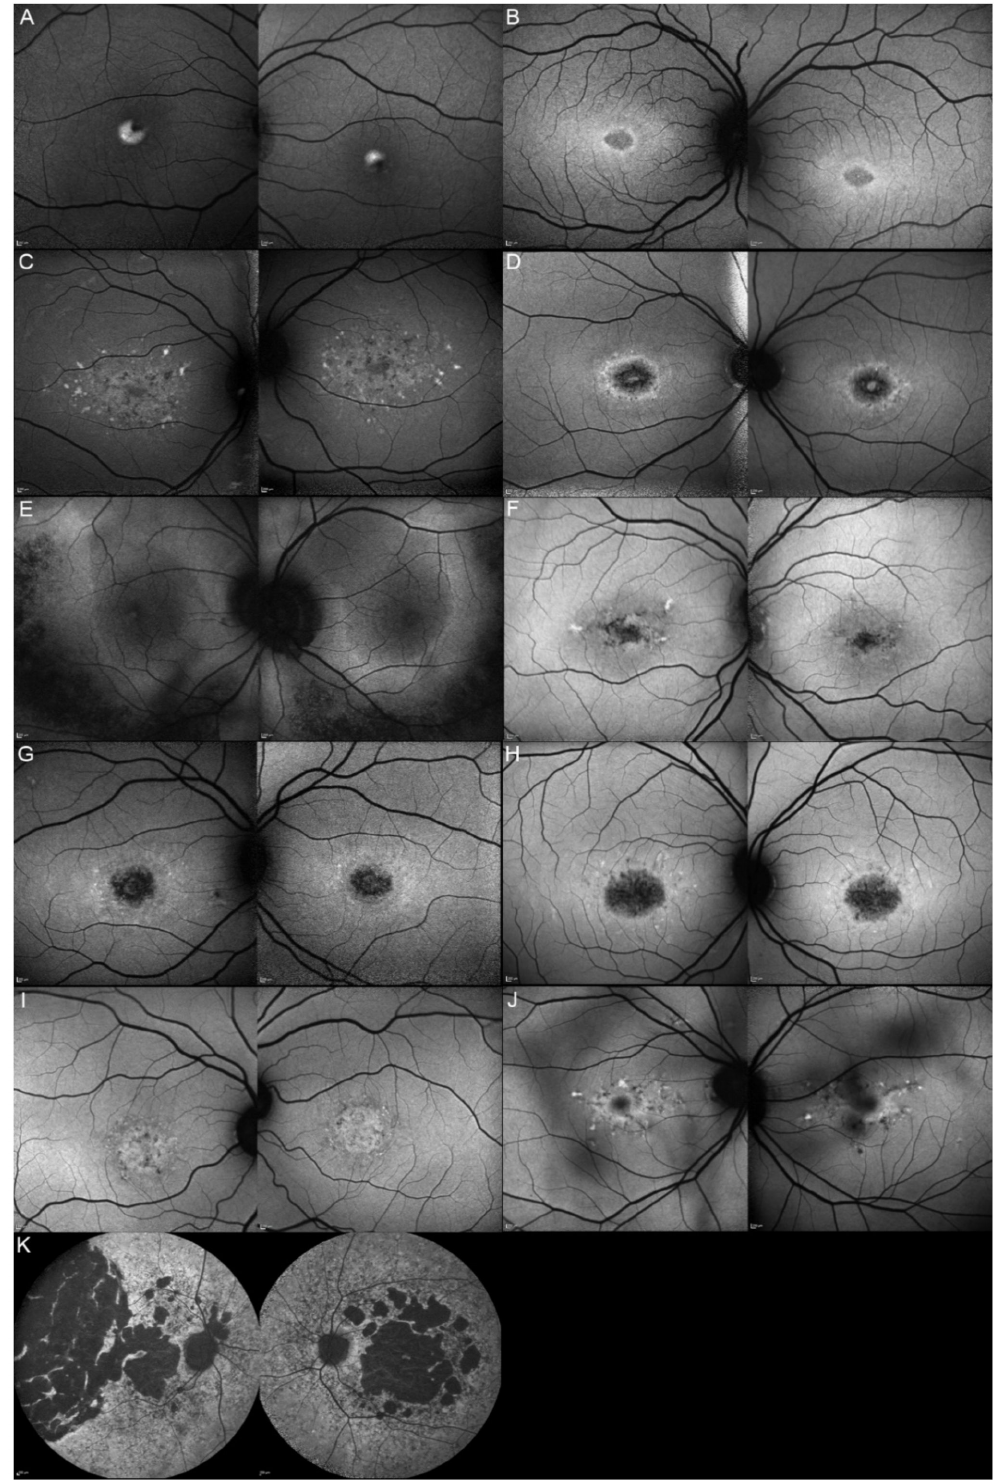
Figure 3. Fundus autofluorescence (FAF) imaging of patients harboring pathogenic bi-allelic ABCA4 variants. Patient 1/II.2 ( A ), patient 2/II.1 ( B ), patient 3/II.2 ( C ), patient 4/II.2 ( D ), patient 5/II.2 ( E ), patient 6/II.2 ( F ), patient 7/II.1 ( G ), patient 8/III.2 ( H ), patient 10/I.2 ( J ), and patient 11/III.1 ( K ). For each patient, the left panel shows the right eye, and the right panel the left one. The FAF findings are described in detail in Table